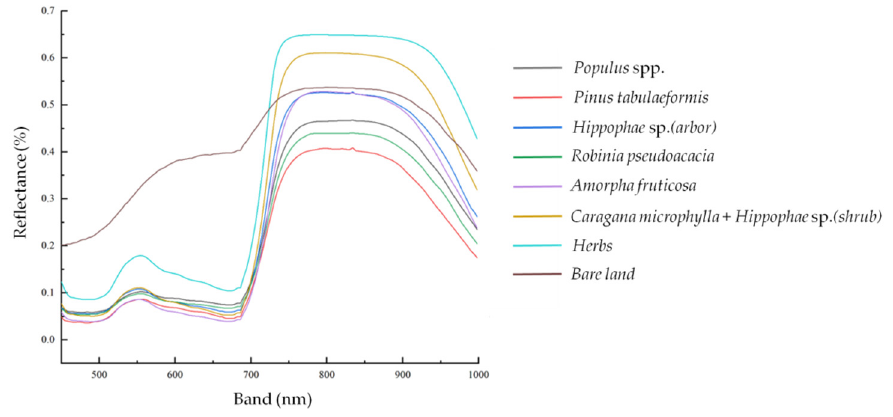
Figure 7. Spectral curves of seven types of vegetation species composition and bare